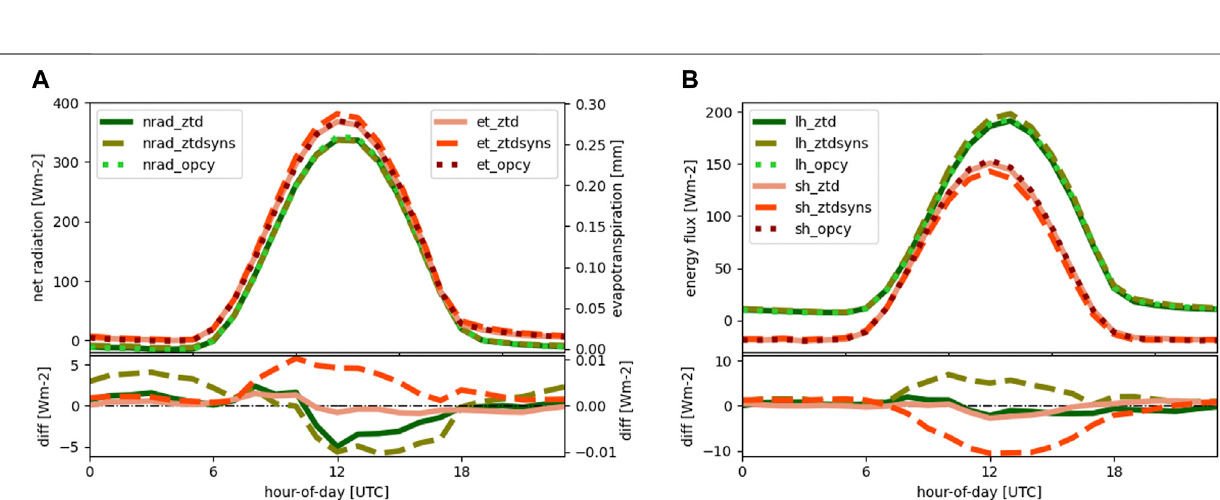
Frontiers in Earth Science |